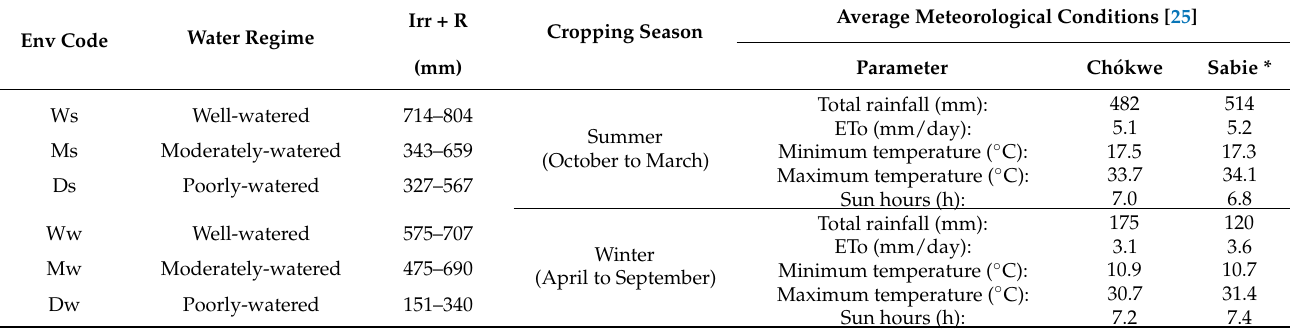
Table 1. Description of trial environments (Env) in the semi-arid climate at Chokwe with clay soil and at Sabie with loamy sand soil texture.